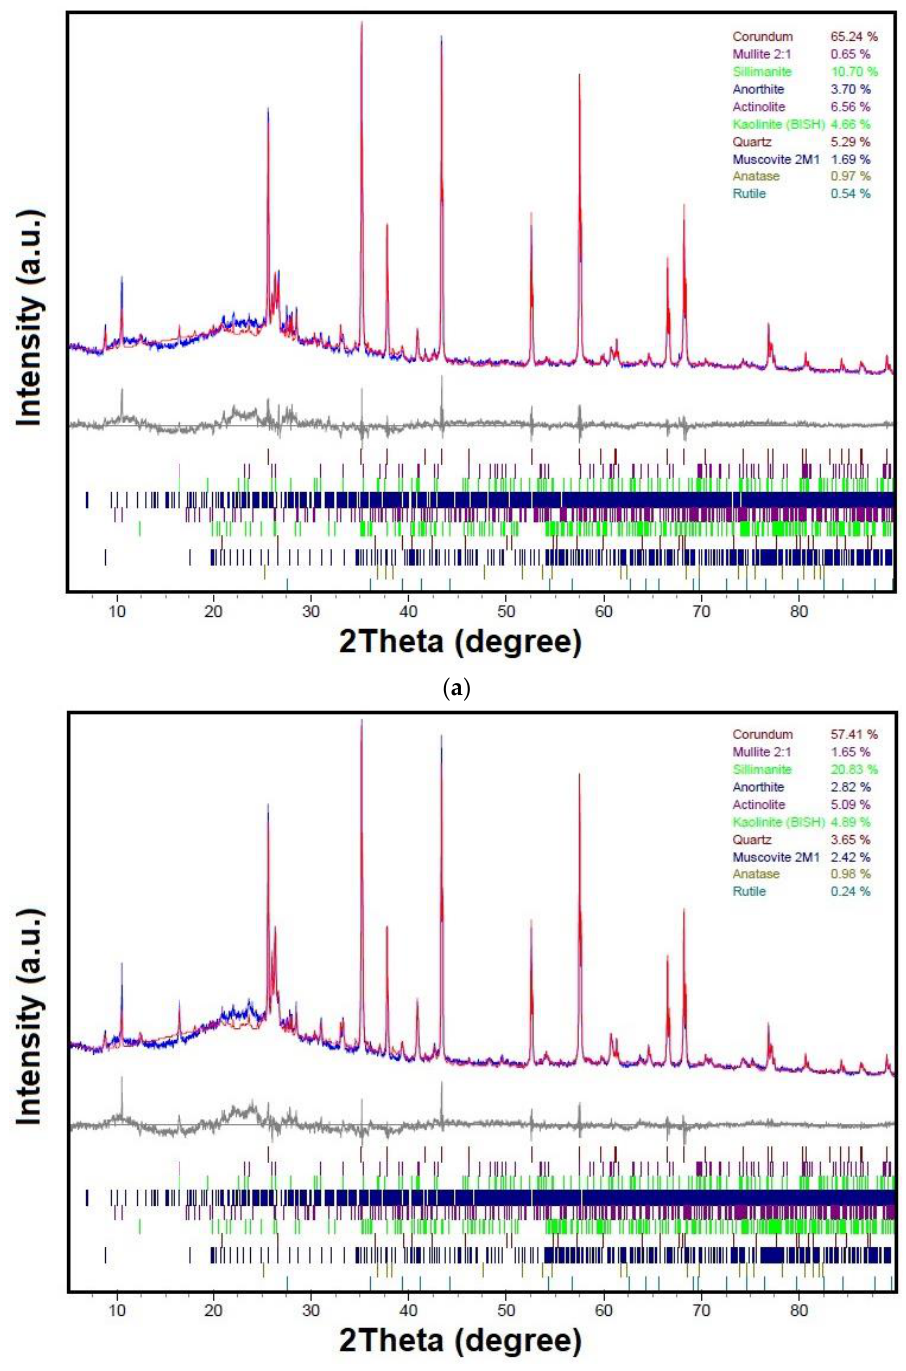
Figure 14. Rietveld refinement plots. ( a ) Rietveld refinement pattern of a normal porcelain insulator prototype; ( b ) Rietveld refinement pattern of a nano-TiO 2 coated porcelain insulator prototype.